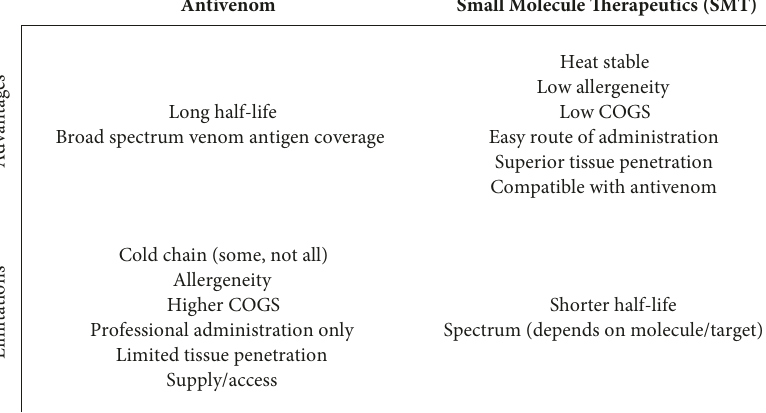
Figure 2: Advantages and limitations of antivenom and SMTs. If proven effective, an SMT might address some limitations of antivenom and vice versa. (COGS = Cost of